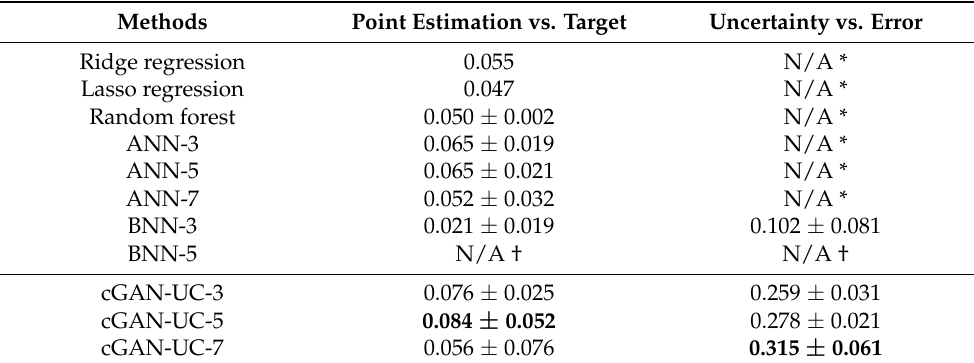
Table 1. Correlation coefficients in the test set. The notation MODEL-n denotes n-layer MODEL. The cGAN-UC indicates the proposed framework, i.e., cGAN for estimation with uncertainty. The means and the standard deviations are obtained over 5 repetitions. In each metric, the best performance is indicated in bold. Methods Point Estimation vs. Target Uncertainty vs. Error Ridge regression 0.055 N/A *